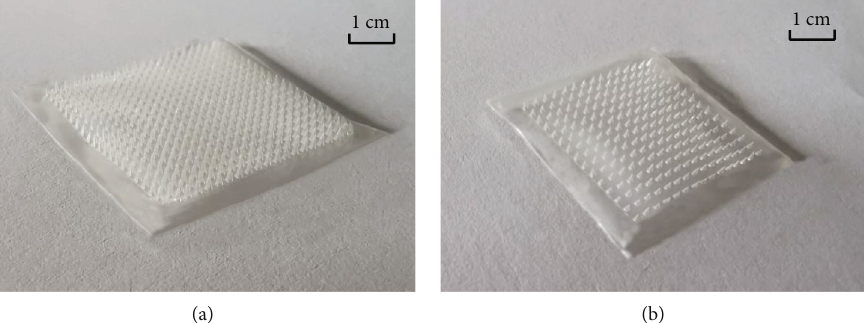
Figure 5: Photos of microneedles prepared by using microwaves for 30min (a) and 35min (b) under the oven-microwave-oven (O-M-O) process.